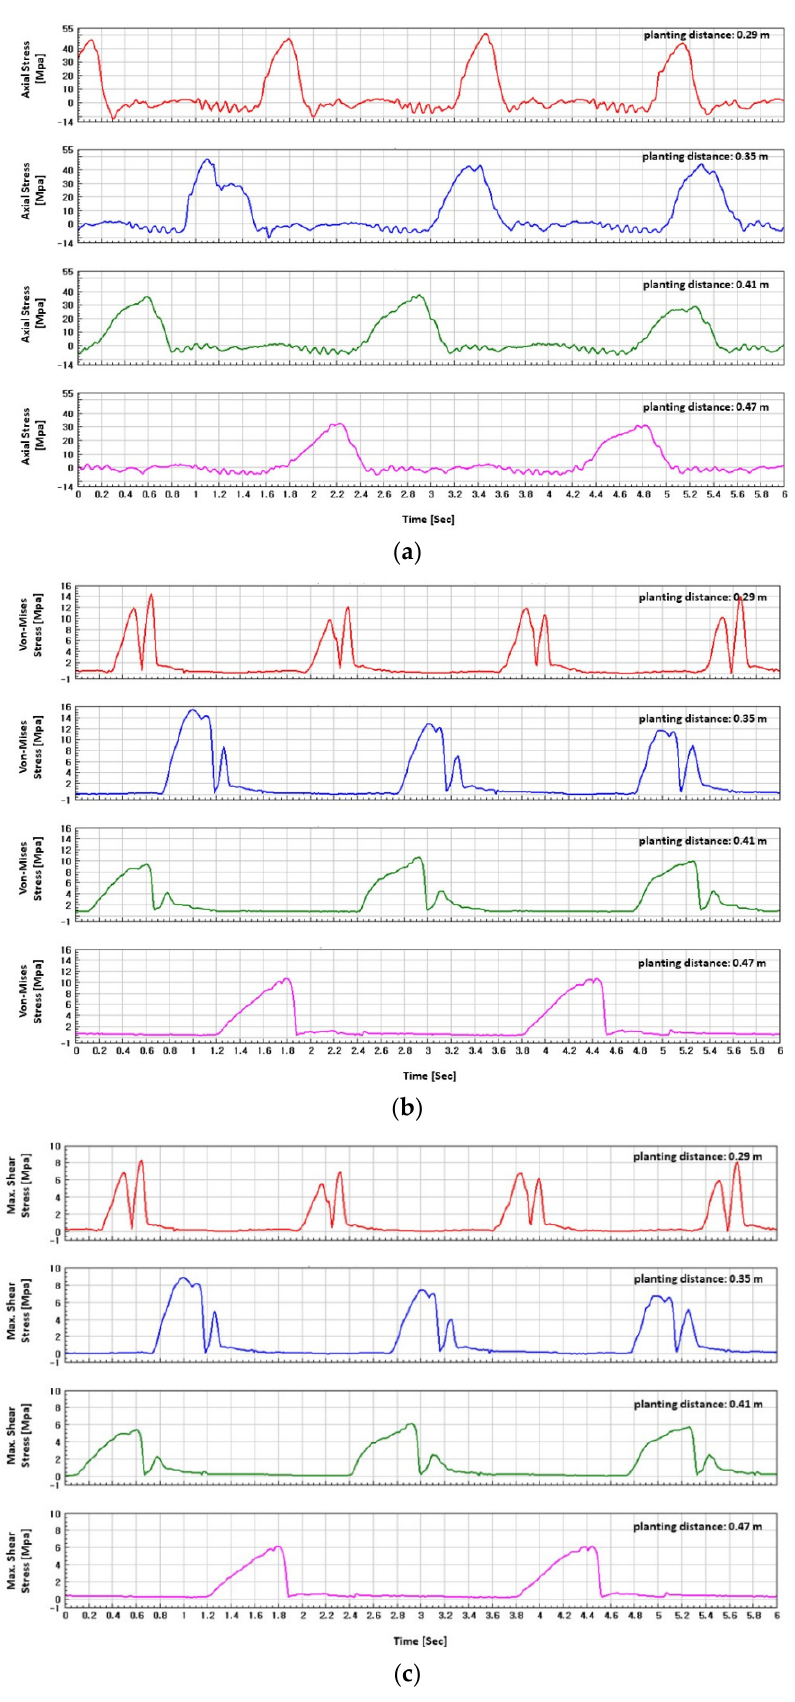
Figure 8. The shape of time series stress data at 750 rpm of engine speed: ( a ) axial stress at S_8, ( b ) Von-Mises stress at S_3, ( c ) maximum shear stress at